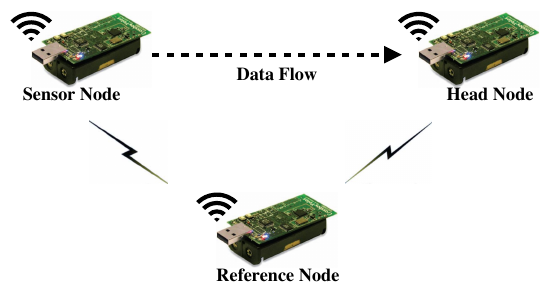
Figure 5. Experiment setup of a real three-hop wireless sensor network (WSN) testbed consisting of five TelosB sensor nodes.